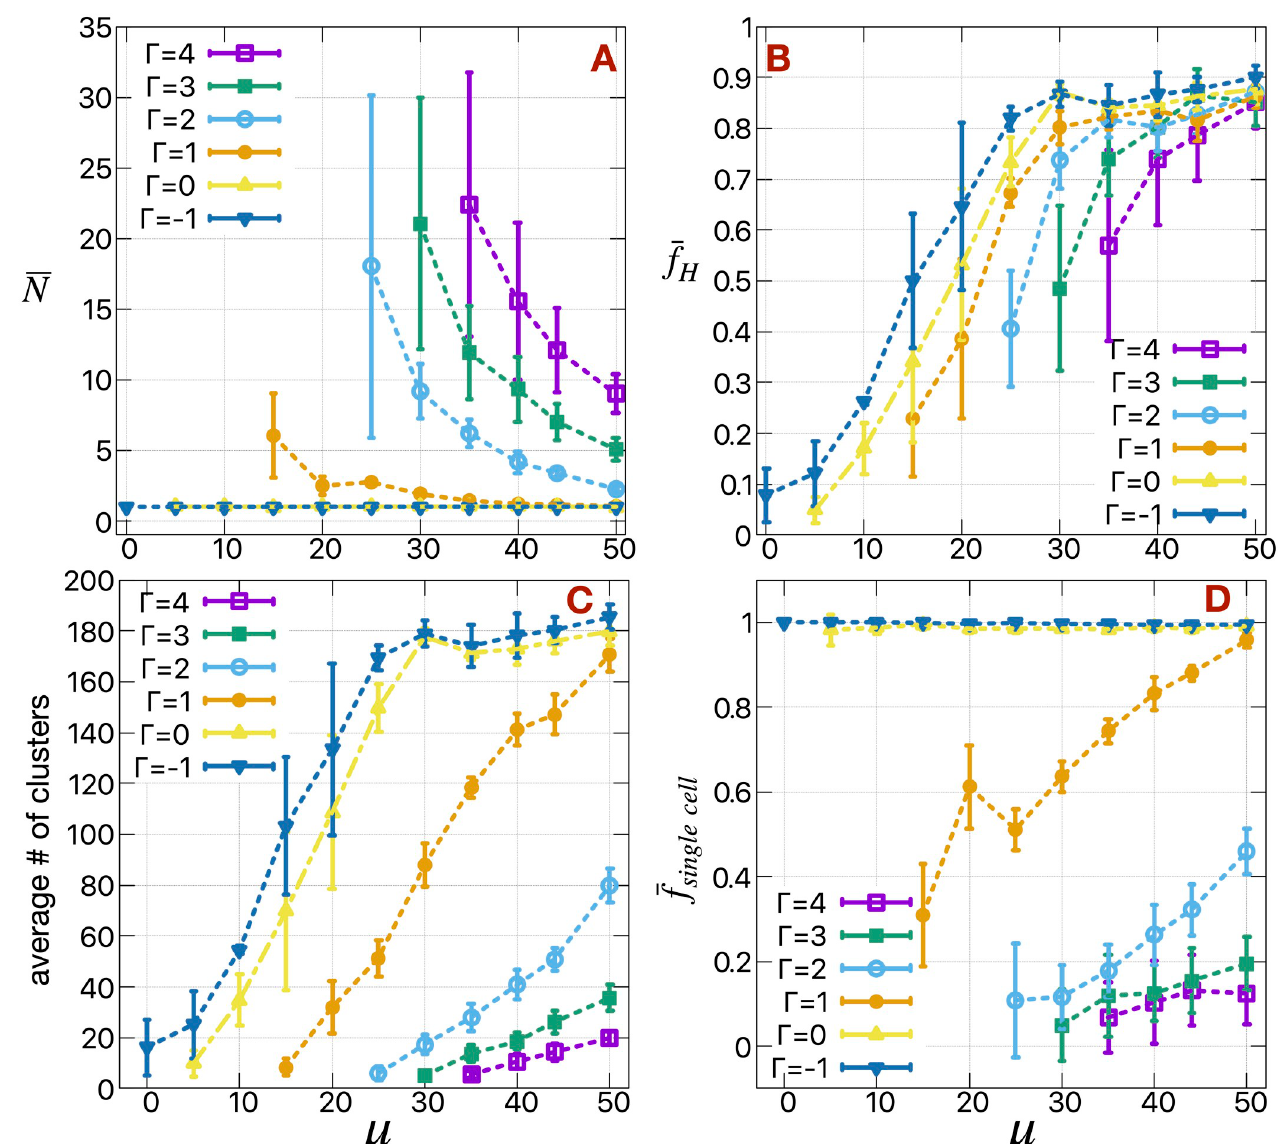
Fig 2. The mean cluster size, the fraction of motile cells in the medium, the average number of clusters and the fraction of single cell clusters as a function of motile forces and cell-medium surface tension. (A) The mean cluster size ( N ) of H cells in the medium, (B) the fraction of H cells ( f the medium, (C) mean number of H cell clusters in the medium and (D) fraction ( f function of motile forces ( μ ) of the H cells for different values of surface tension between H cells and medium (m) γ the simulated data as error